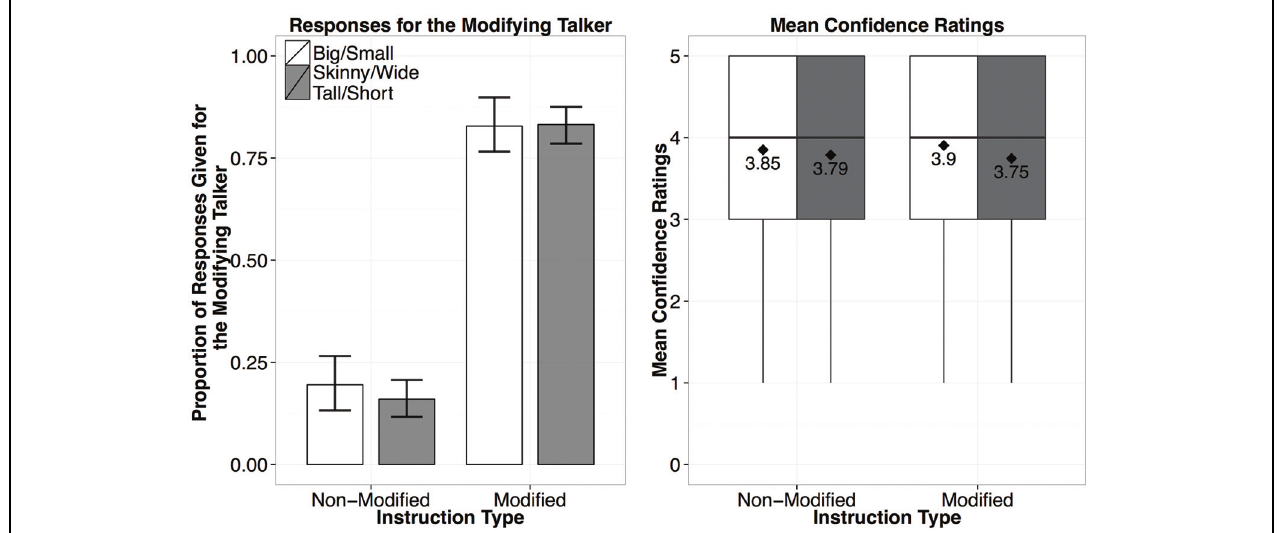
FIGURE 3 | Results from Experiment 1, showing the proportion of responses given for the modifying talker by Instruction Type (left), and the confidence ratings for responses by Instruction Type (right; diamond dots reflect the mean rating out of